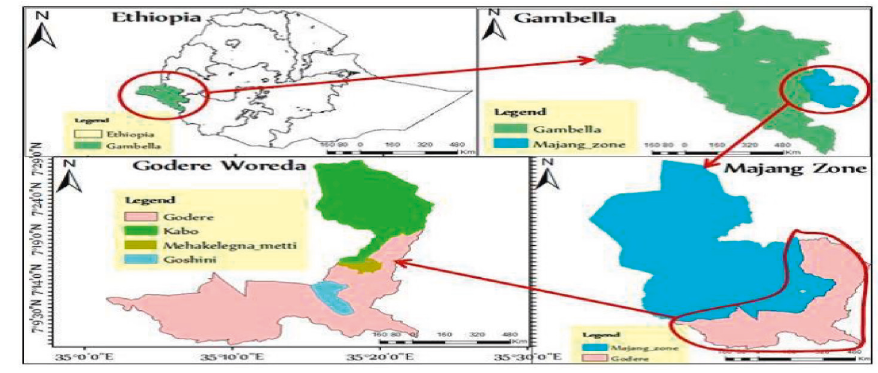
Figure 1: Map of study area. Source: ArcGIS,